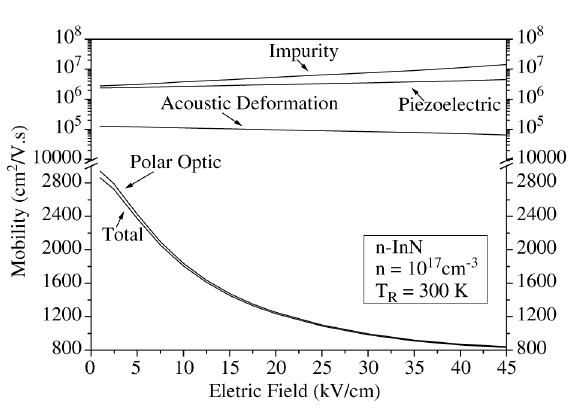
Figure 4. Electric field dependence of the different contributions to the electron mobility in wurtzite n-AlN. The lattice temperature is T = 300 K and n = 10 17 cm -3 . 0